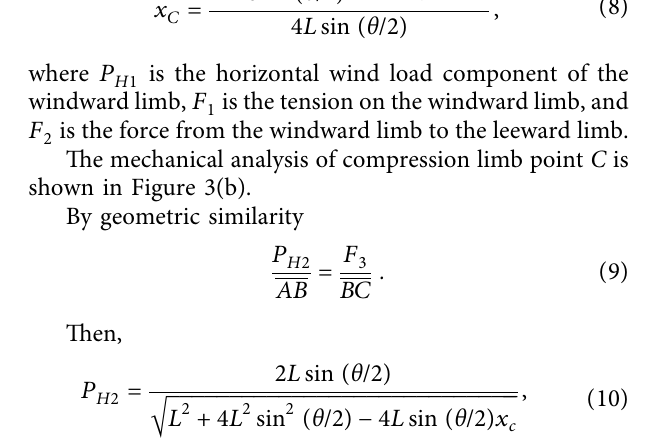
Figure 2: Te windage yaw of the V -type insulator